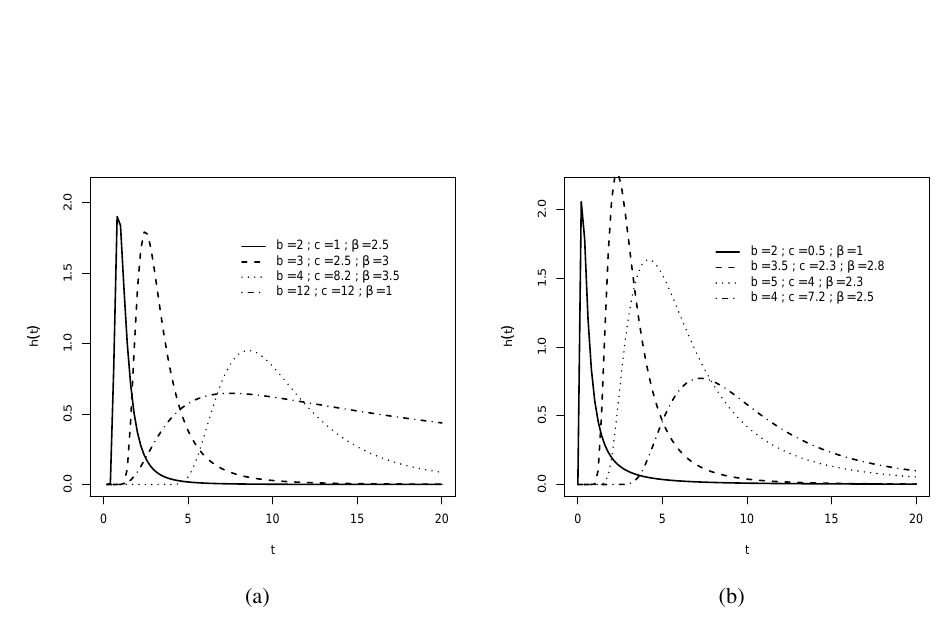
Fig. 3. Kumaraswamy inverse Weibull hazard